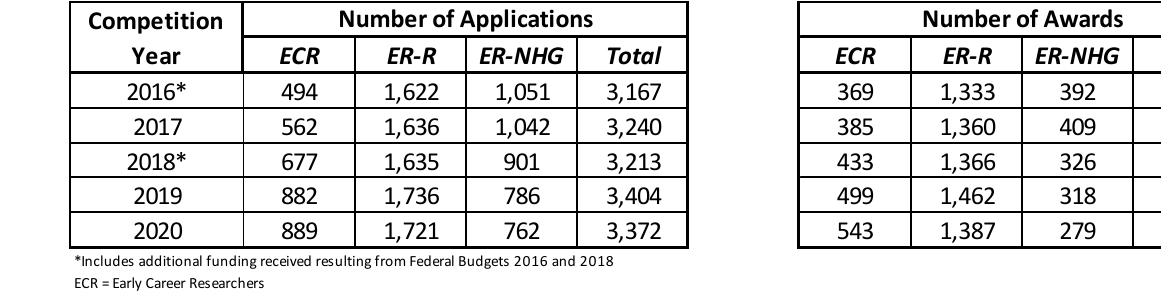
Number of Applications and Awards by Category of